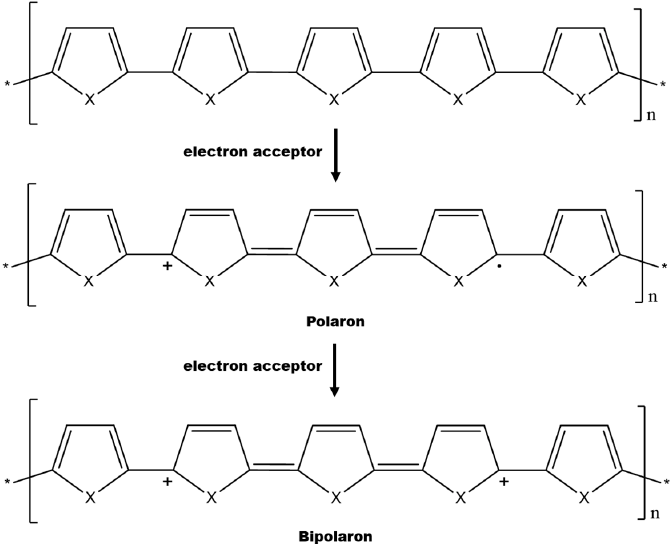
Figure 1. p-doping of heterocyclic polymers (X = S, N, O): a polaron and a bipolaron are subsequently introduced upon oxidation.